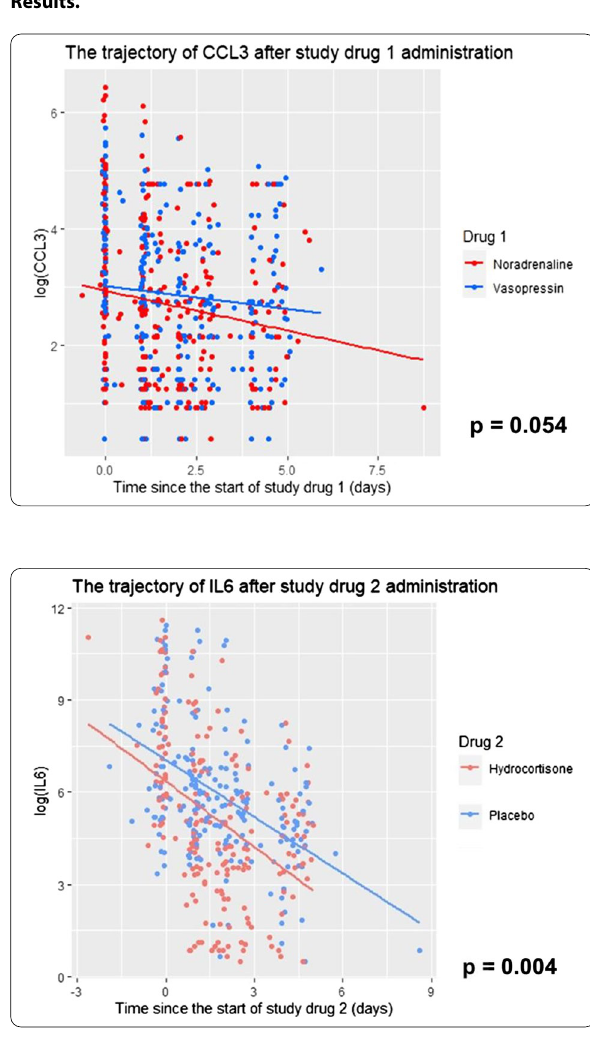
the analysis of noradrenaline versus vasopressin was repeated adjust- ing for this.